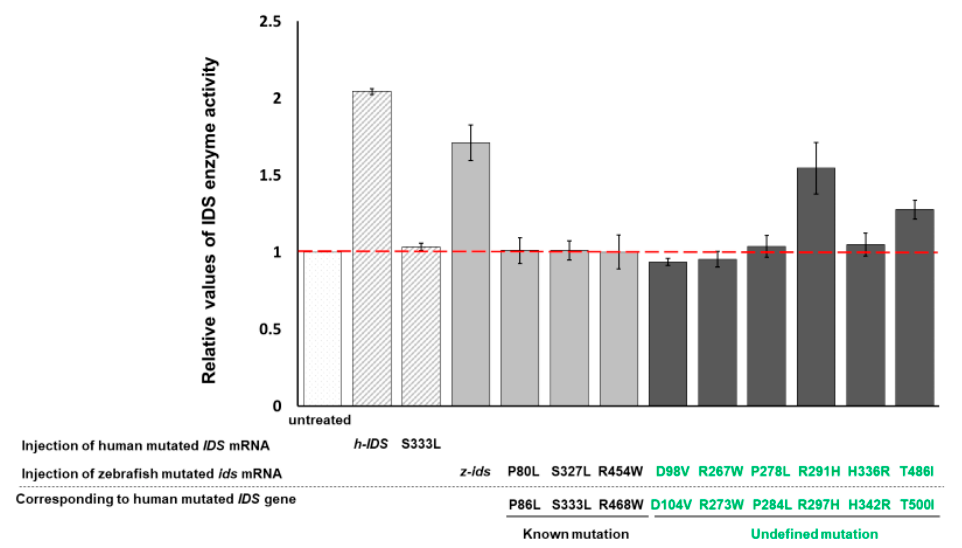
Figure 2. E ff ect of mutated ids mRNA overexpression on the IDS enzymatic activity of zebrafish embryos. Serving as a control group, the IDS enzymatic activity of the untreated zebrafish embryos at 48 hpf was quantified and normalized as 1 for comparison with the relative IDS activity obtained from the other experimental groups. Zebrafish embryos at one-cell stage were injected with 300-pg human IDS mRNA (h-IDS), zebrafish ids mRNA (z- ids) , and various point-mutated z- ids mRNAs, as indicated. Each point-mutated z- ids corresponding to that of the h-IDS was listed below the black dotted